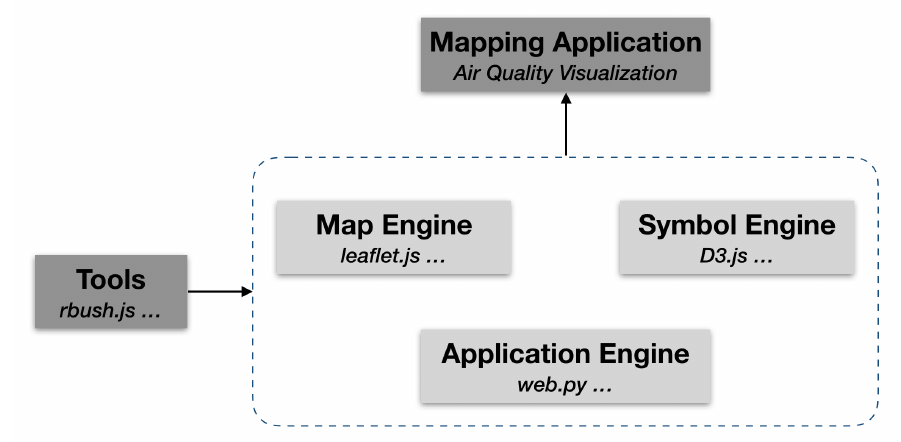
Figure 3. The air quality monitoring application framework. This paper proposes a mashup strategy to make use of multiple visualization and mapping technologies for web mapping